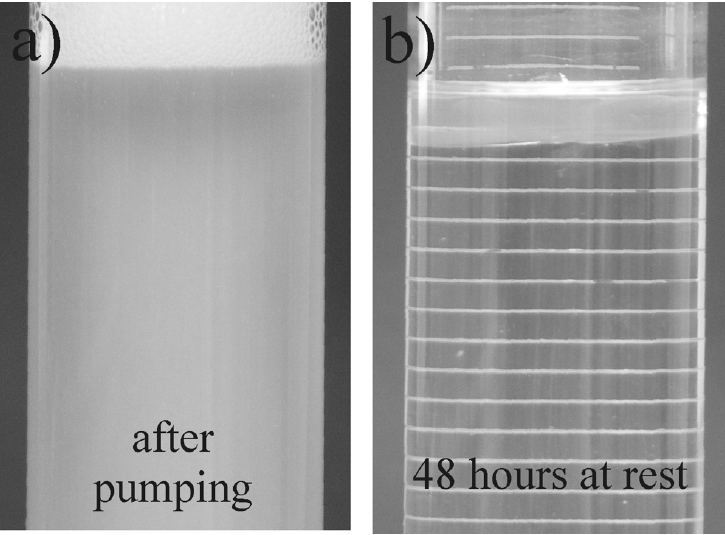
Figure 7. Image of CAPB/DEA solution, directly after sampling from the experimental set-up ( a ) and after 48 h ( b ).